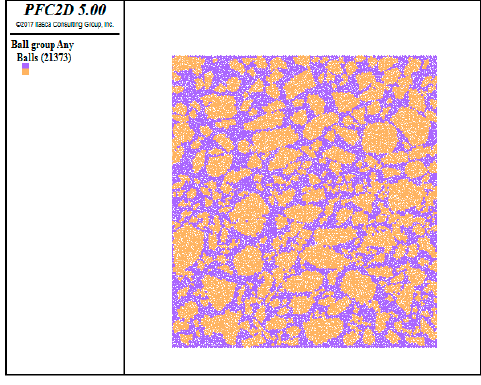
Figure 11. The reconfiguration model.